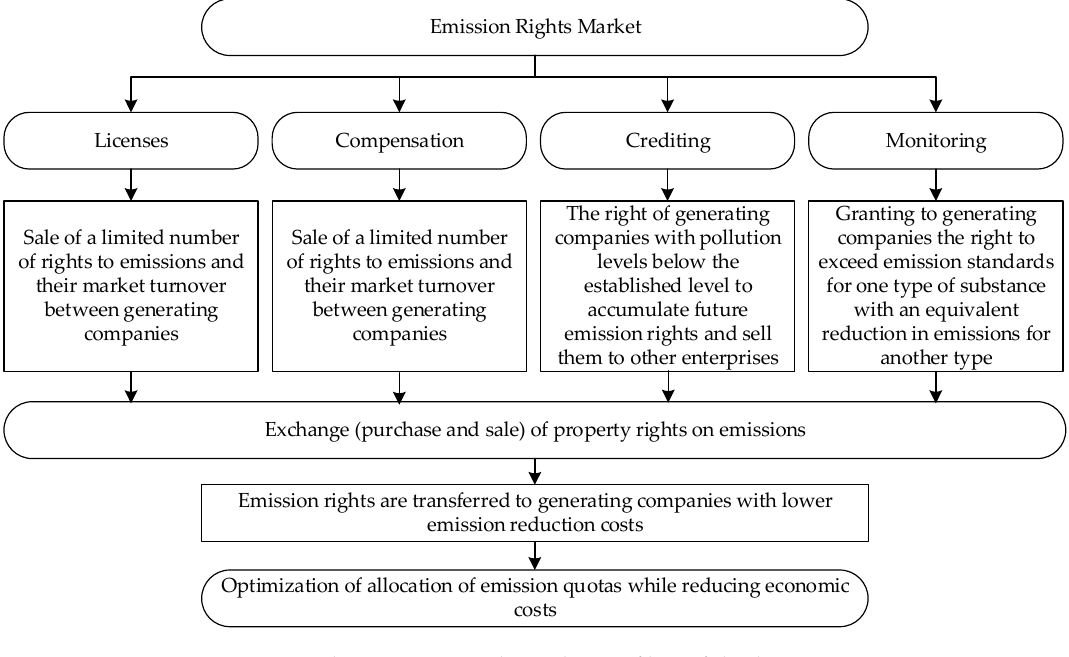
Figure 3. The emissions trading scheme of harmful substances.